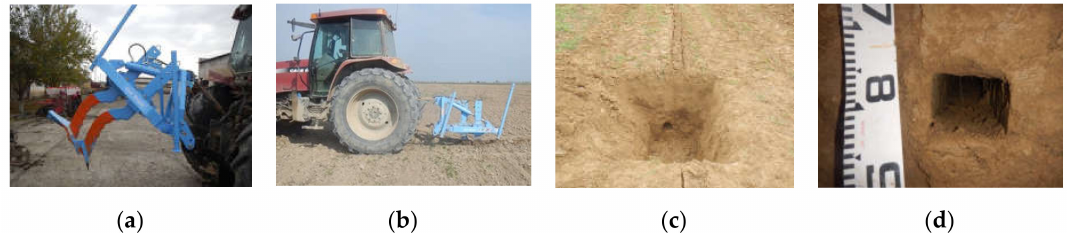
Figure 3. Construction of a cut-drain: ( a ) Equipped drilling machine; ( b ) towing the drilling machine; ( c ) cut-drain in soil profile (depth: 60–90 cm); and ( d ) constructed cut-drain (width: 10 cm, height: 10